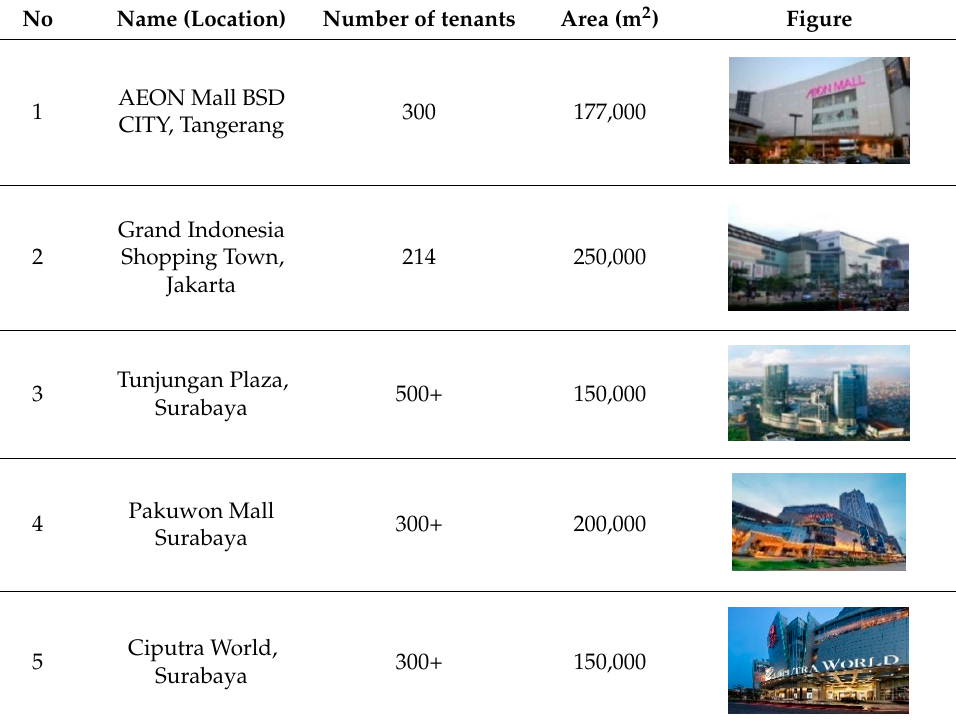
Table 1. Several shopping centers in Indonesia 2021.